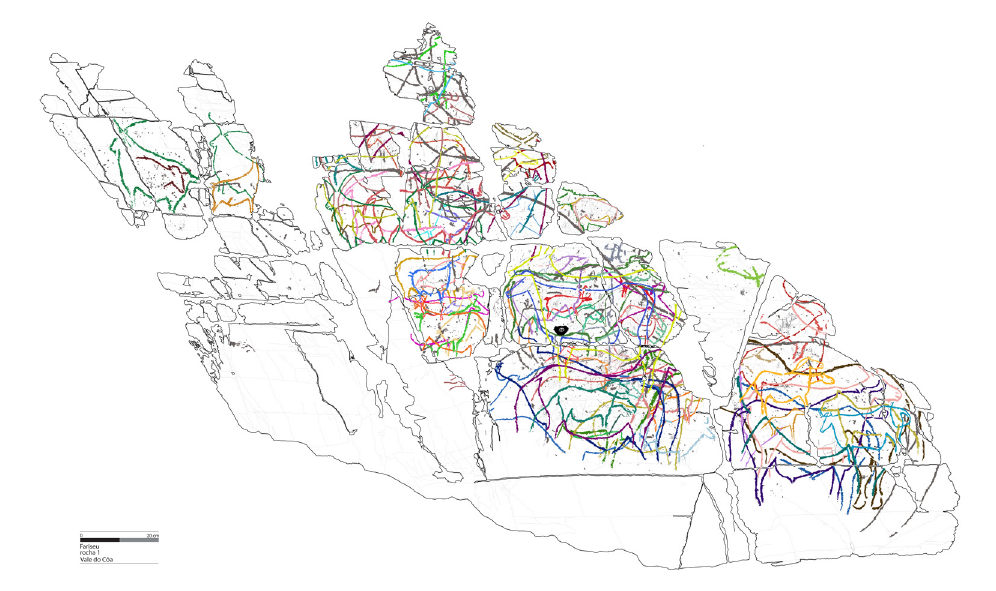
Figure 10. Fariseu Rock 1, Côa Valley, Portugal. This heavily superimposed surface possesses a multitude of engraved motifs. Tracing: Fernando Barbosa, assisted by Manuel Almeida, João Félix and André Tomás